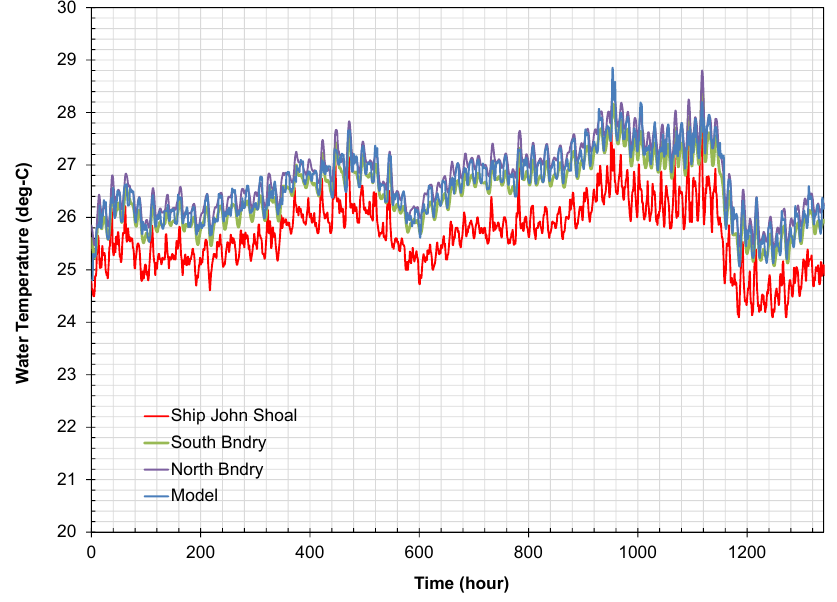
Figure 8. Estimated and modeled temperature at a point in the middle of the nested grid.